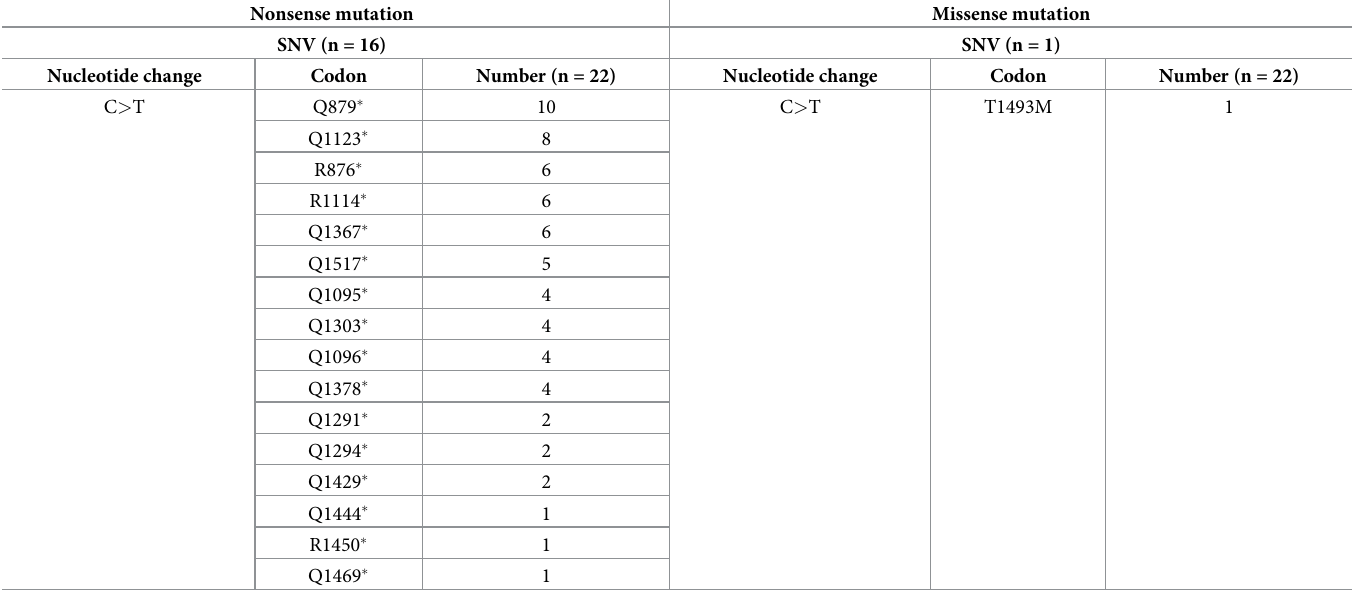
Table 4. APC mutation.